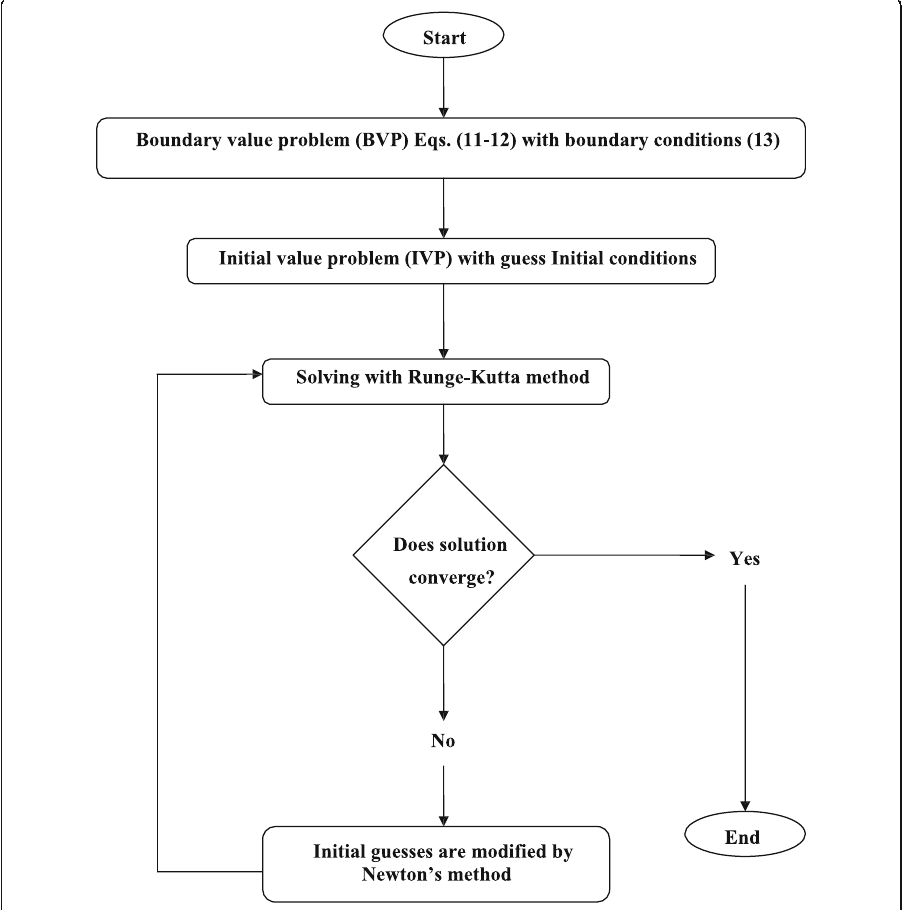
Fig. 2 Flow chart for describing the overall simulation process with the shooting method